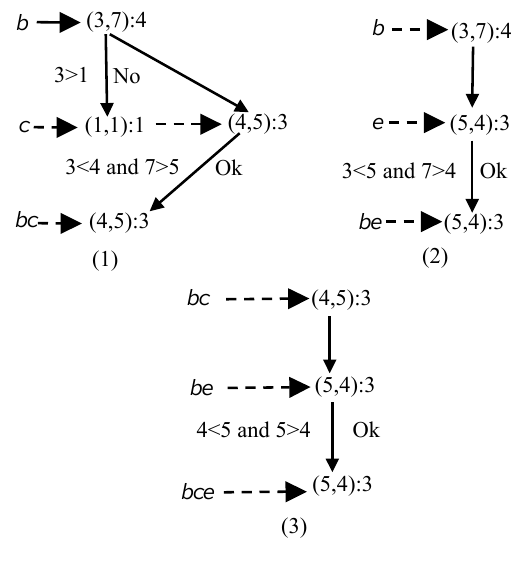
Fig. 4. The Node-lists of bce in Example 1